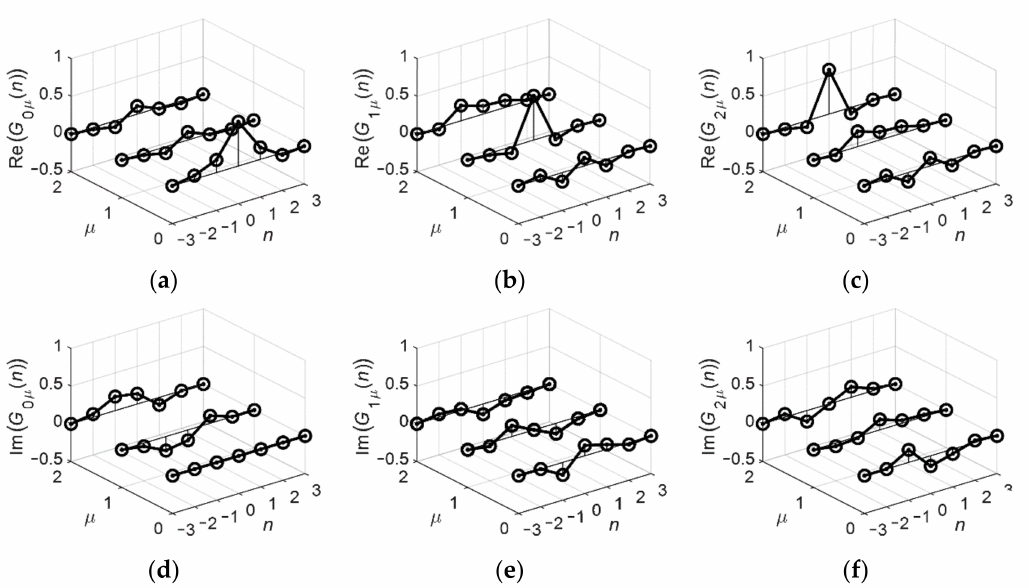
Figure 6. Real ( a – c ) and imaginary ( d – f ) parts of 1 D impulse responses G ν , µ ( n ) of frequency shift filter corresponding to the sliding window filter.